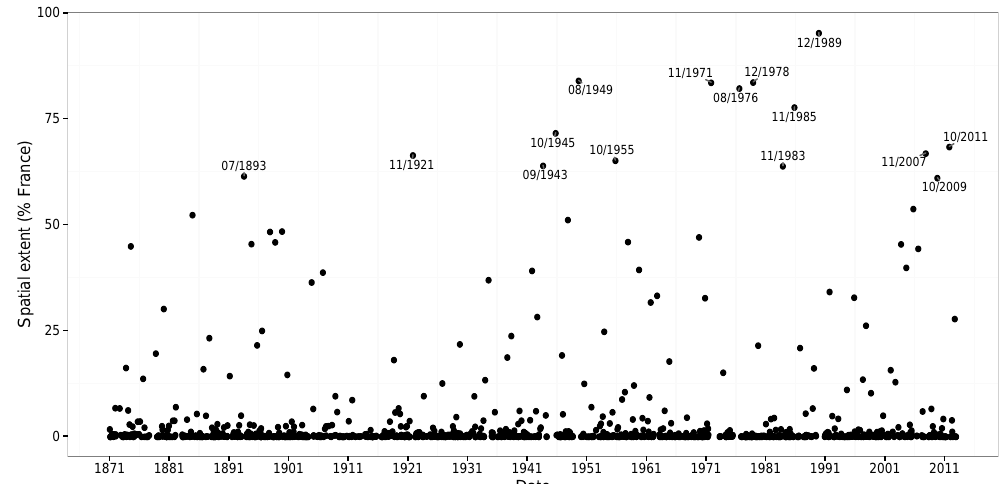
Figure 14. Median value of the maximum spatial extent of spatio-temporal events from individual ensemble members of SCOPE Hydro over the 1871–2012 period. See text for details. x -axis coordinates are the median of the dates when the maximum spatial extent is reached. Years and months of the median dates are labelled for events with a spatial extent over 60% of France.